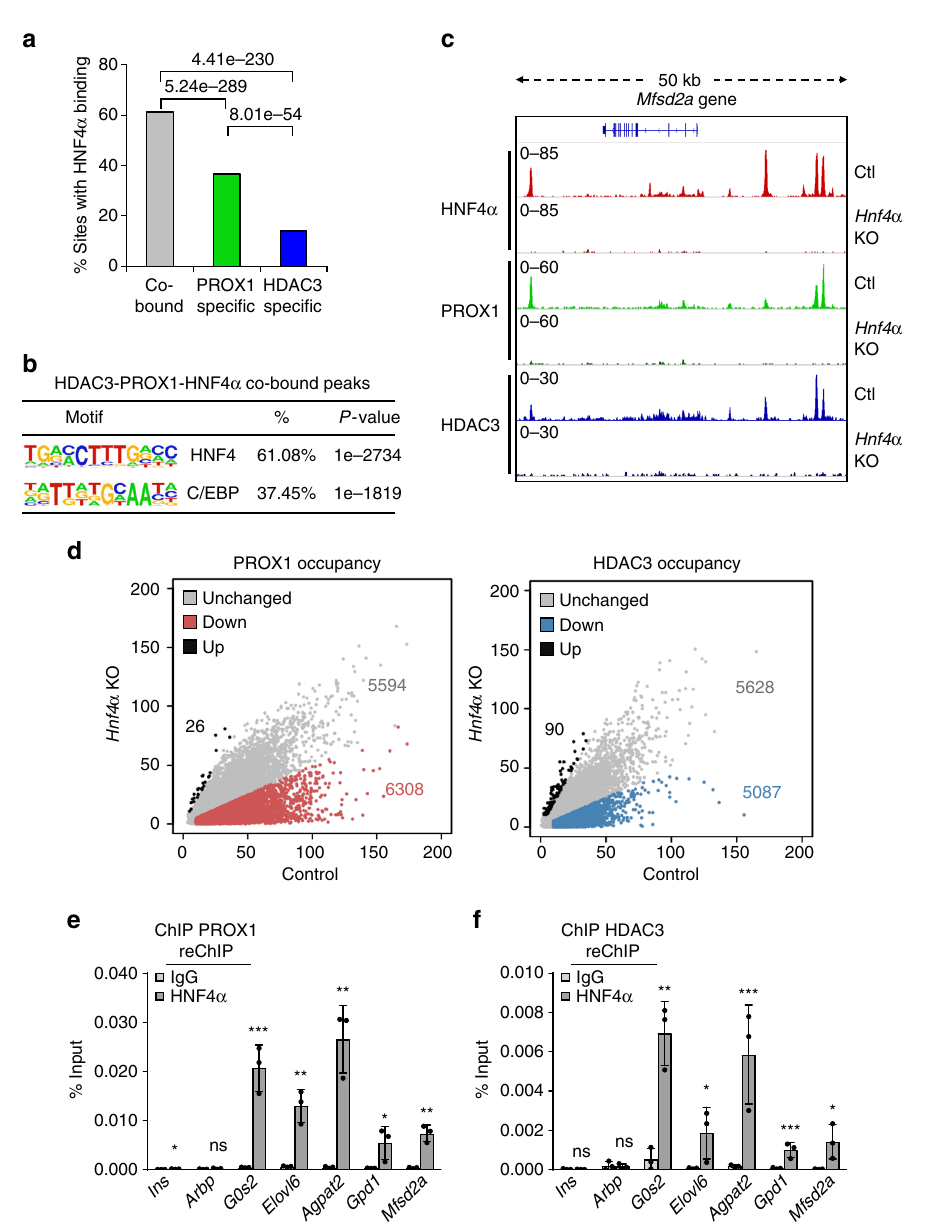
Fig. 3 The HDAC3 – PROX1 module is recruited by HNF4 α in liver. a Comparison of HNF4 α binding ( > 2 rpm, fi ltered on the HNF4 α KO, 50% minimum overlap) at overlapping and non-overlapping peaks in the HDAC3 and PROX1 cistromes from Fig. 2a. Numbers above brackets indicate P -values, χ 2 test. b HOMER motif analysis of peaks co-bound by HDAC3, PROX1, and HNF4 α displaying over-represented sequences. c Representative browser tracks of HNF4 α , PROX1, and HDAC3 ChIP-seq in Hnf4 α fl / fl livers infected with AAV8 TBG Egfp (Ctl) or Cre ( Hnf4 α KO). Indicated scales are in RPTM. d Scatter plots of PROX1 ( left ) and HDAC3 ( right ) ChIP-seq in control versus Hnf4 α KO. Red and blue shaded regions indicate a twofold decrease in peak intensity upon loss of HNF4 α . e , f Co-occupancy of HDAC3 – PROX1 and HNF4 α as indicated by ChIP – reChIP ( n = 3) from liver. Legend indicates reChIP antibody following primary HDAC3 or PROX1 ChIP elution. Data are presented as mean ± s.d, one-tailed unpaired Student ’ s t -test, * P < 0.05, ** P < 0.01, *** P < 0.001, ns not signi fi